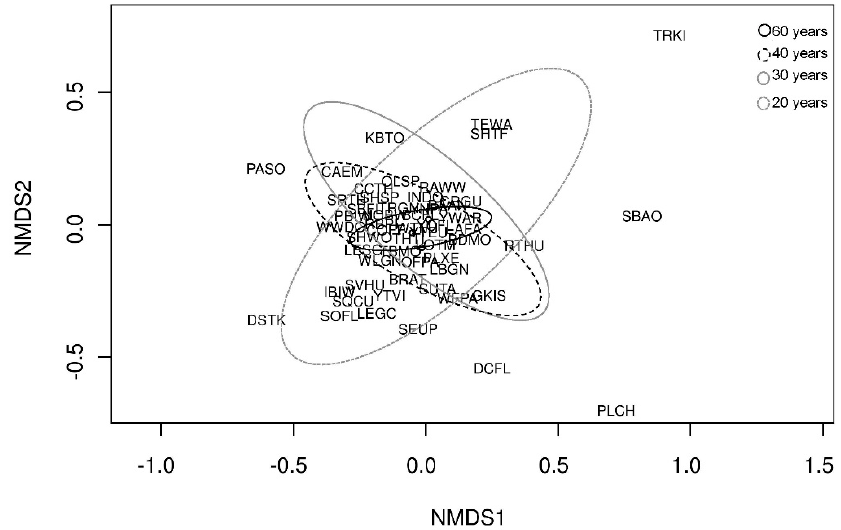
Figure 6. Nonmetric Multidimensional Scaling (NMSD) of bird species presence at the different forest age classes (20, 30, 40, 60 years old). n = 16 sites. Forest age ordiellipses represent 95% CI. Ordiellipses overlapping show non-differences on species compositions at different forest ages. Species names are represented by four letters code (see Table 1 for full scientific names).